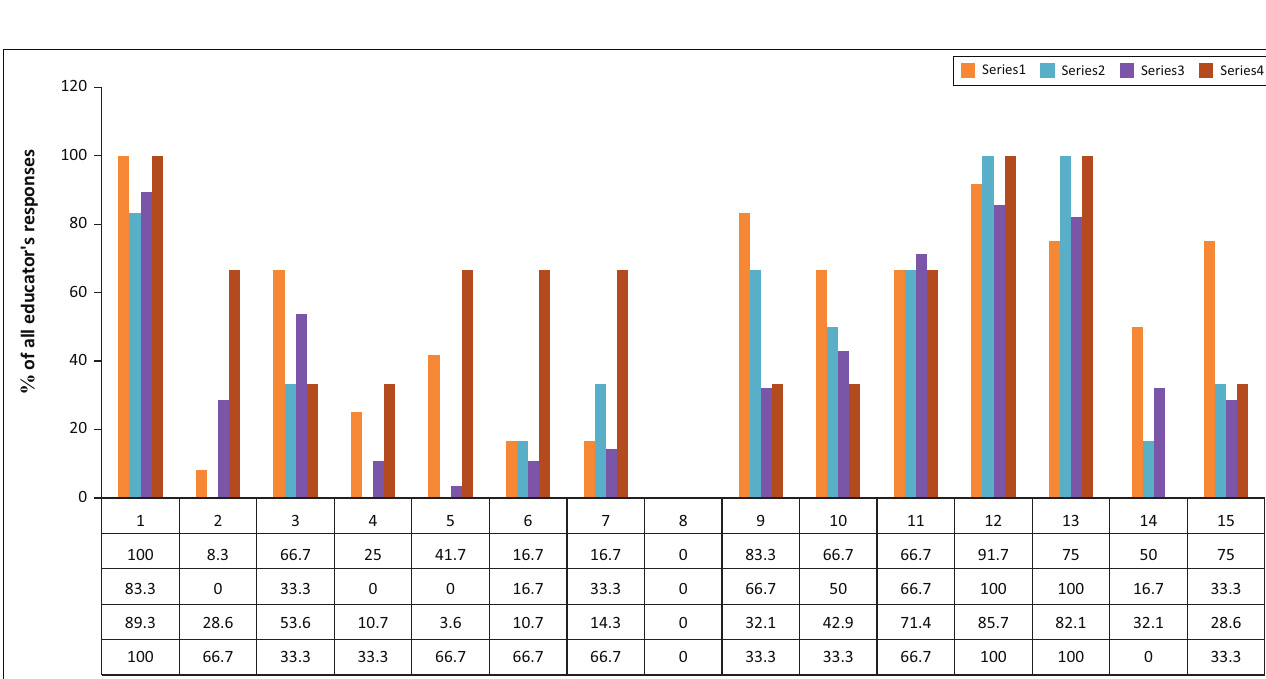
FIGURE 1: Overall trend of psychosocial challenges observed by all